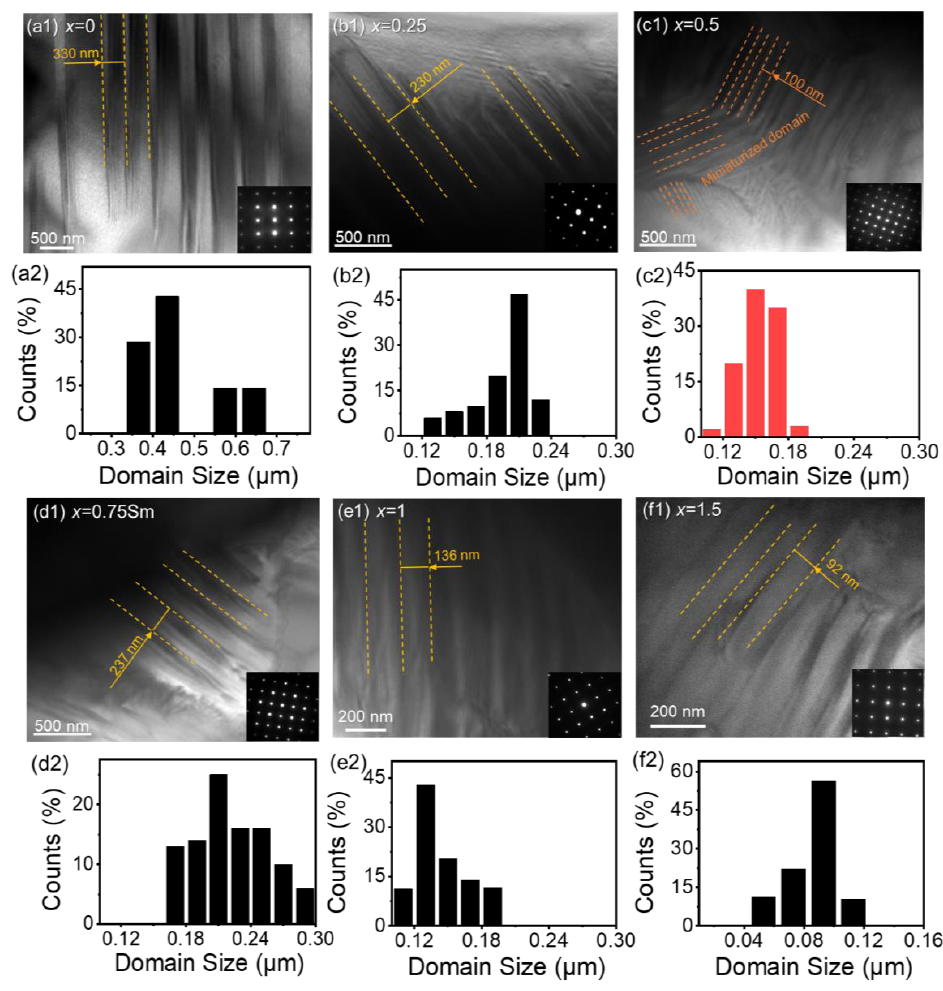
Figure 5. ( a1 – f1 ) Transmission electron microscope (TEM) observation of the (100) zone axis and ( a2 – f2 ) the corresponding domain size distribution of the BCZT- x Sm ceramics with x = 0, 0.25, 0.5, 0.75, 1, and 1.5, where BCZT-0.5Sm displayed unexpected miniaturized domains.